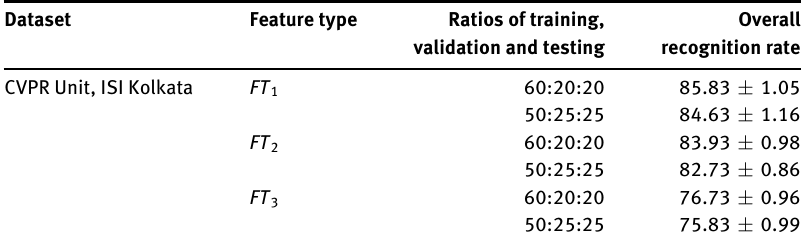
Table 2: Overall Average Recognition Performance (in Terms of F -Measure) for Both Ratios. Dataset